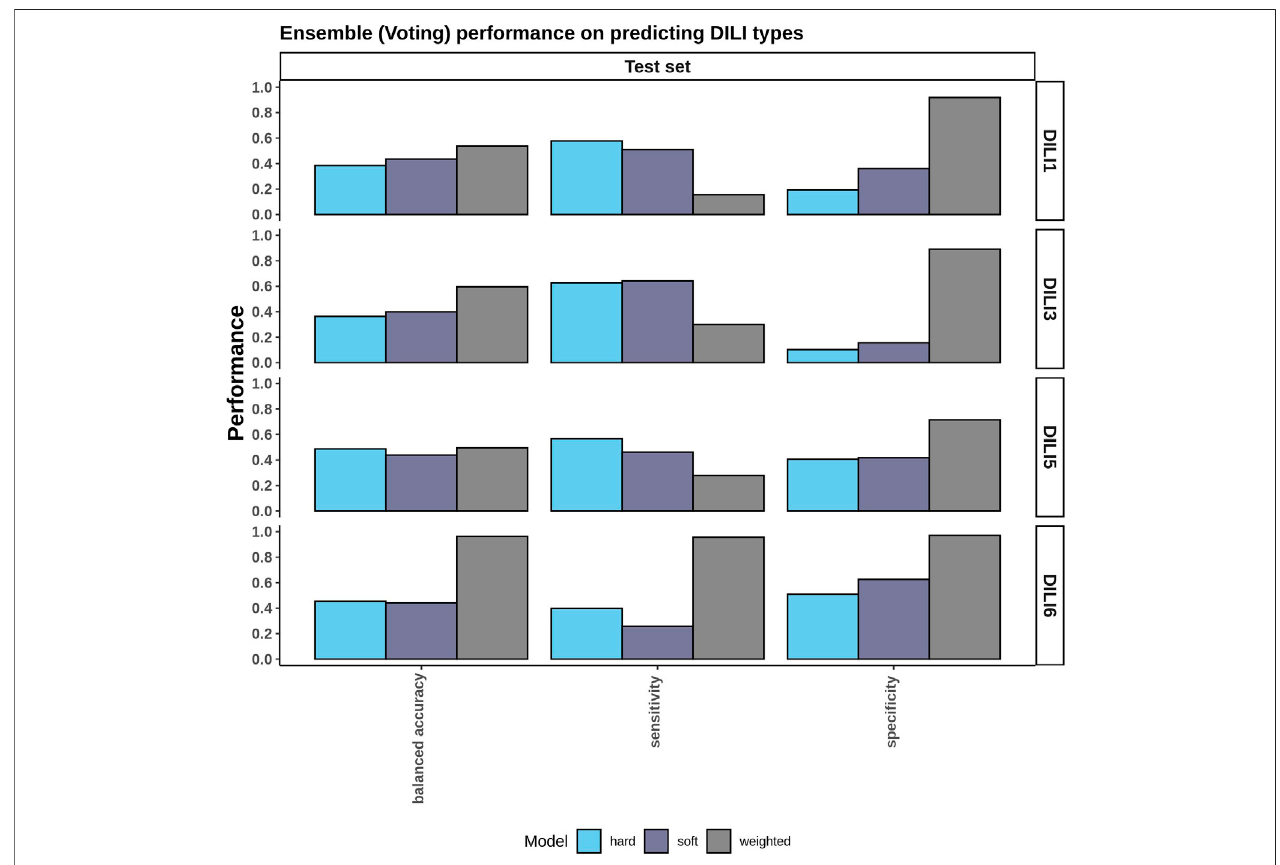
FIGURE7| EnsembleVotingMethodPerformance.Toincorporatethevarioustypesofdataprovidedensemblemethodsincludinghard,soft,andweightedvoting were tested using the top three performing models for each DILI type.